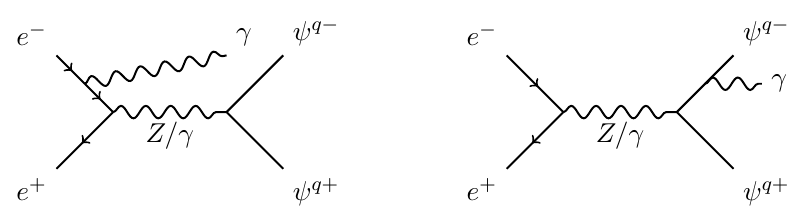
Figure 5 . Contributing Feynman diagrams for e + e (cid:0) ! q + q (cid:0) (cid:13) . (Left): initial state radiation. (Right): (cid:12)nal state